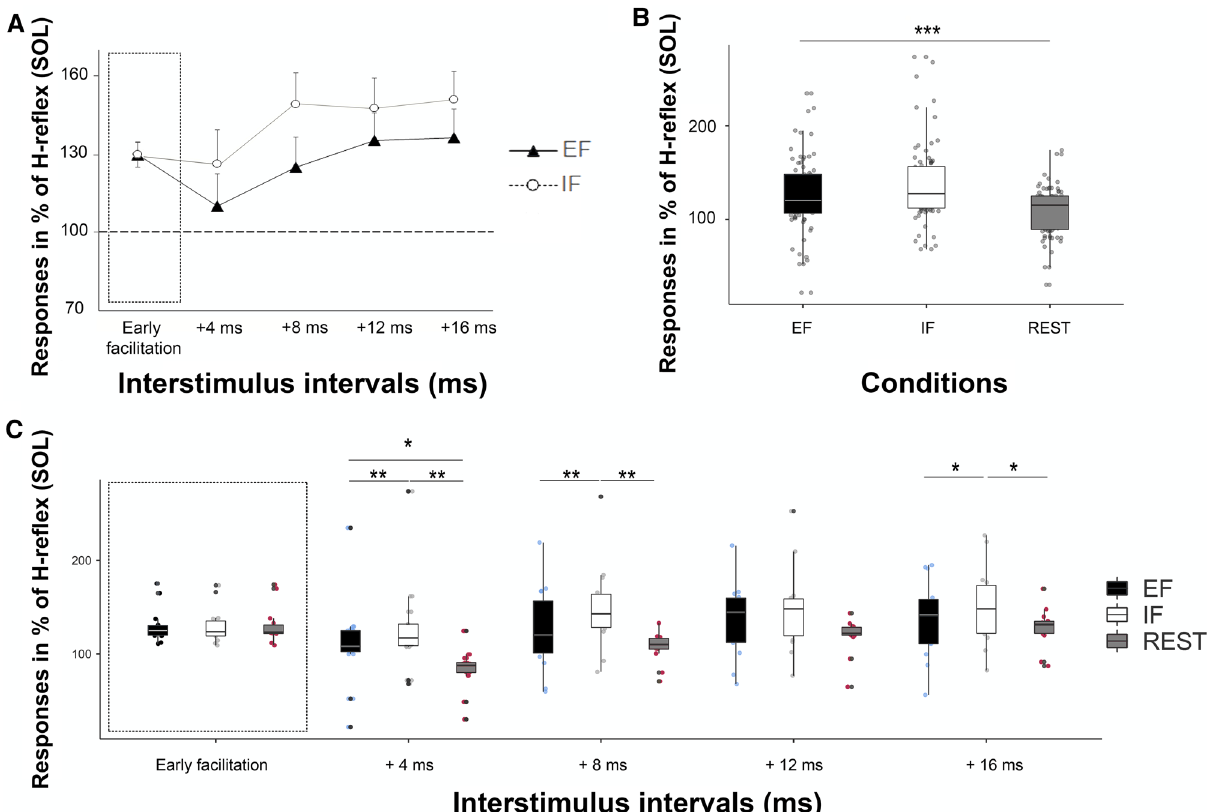
Figure 3. In order to normalise the conditioned H-reflexes in percent (%) for each participant, the unconditioned test H-reflex (not represented) was considered as the baseline. In all graphs, black boxplots/ shapes represent the external (EF), the white ones the internal focus of attention (IF) and the grey ones the REST condition (no contraction and no focus). On the abscissa of ( A ) and ( C ), the early facilitation was